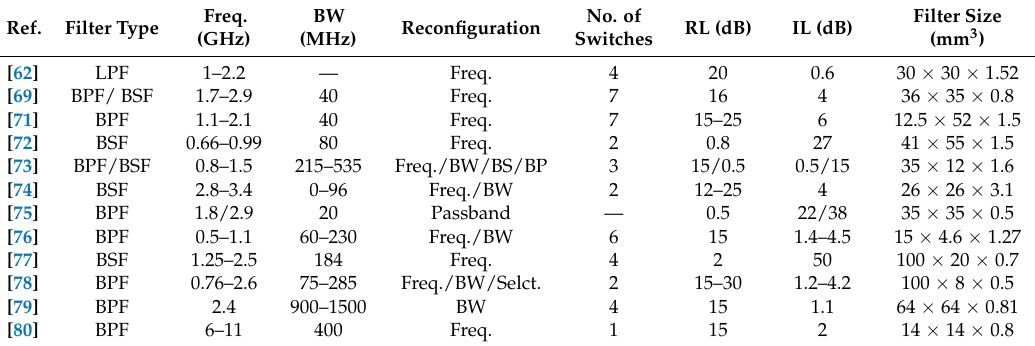
Table 1. Performance comparisons for some recent microstrip tuneable filter designs.